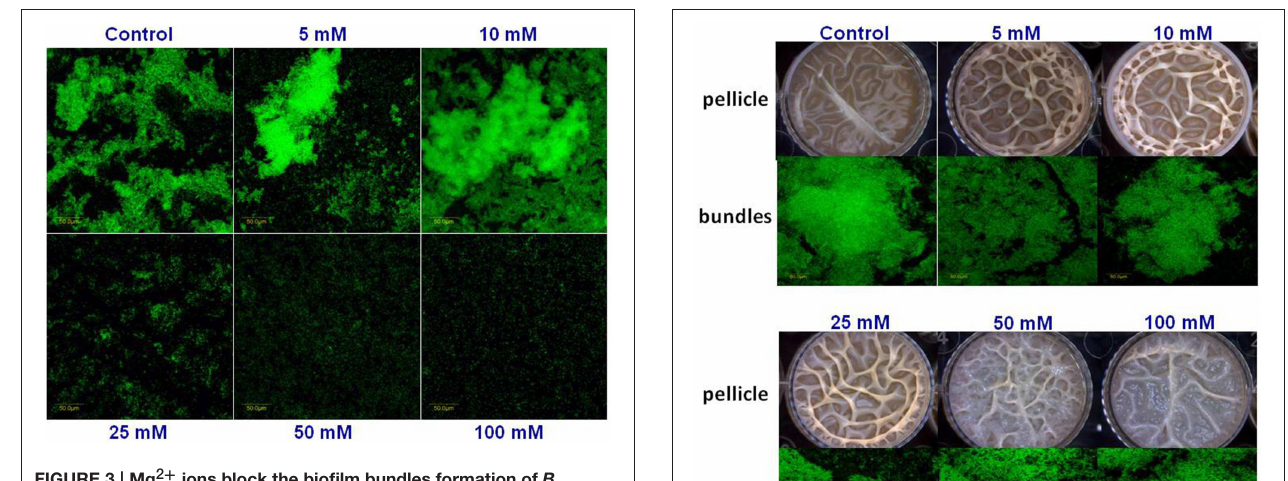
FIGURE 3 | Mg 2 + ions block the biofilm bundles formation of B. subtilis . CLSM images of fluorescently tagged B. subtilis cells (YC161 with P spank -gfp ) following 24h incubation in biofilm promoting medium.